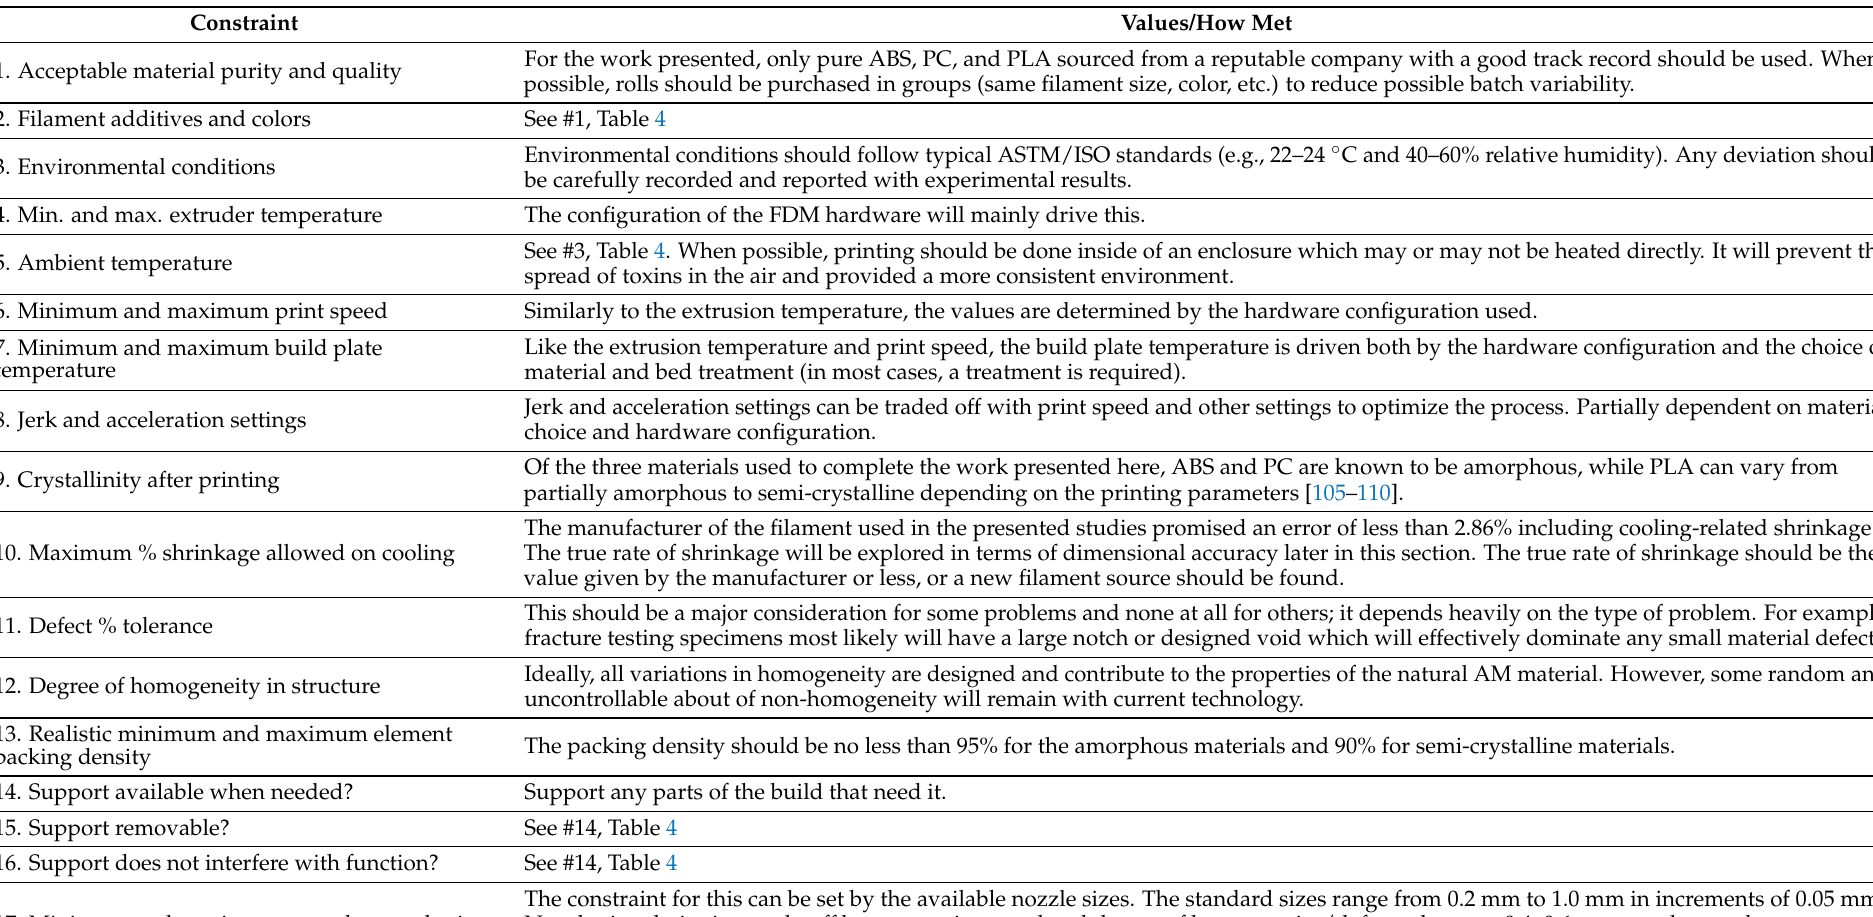
Table 4. FDM manufacturability constraint refinement for selected materials (ABS, PLA, and